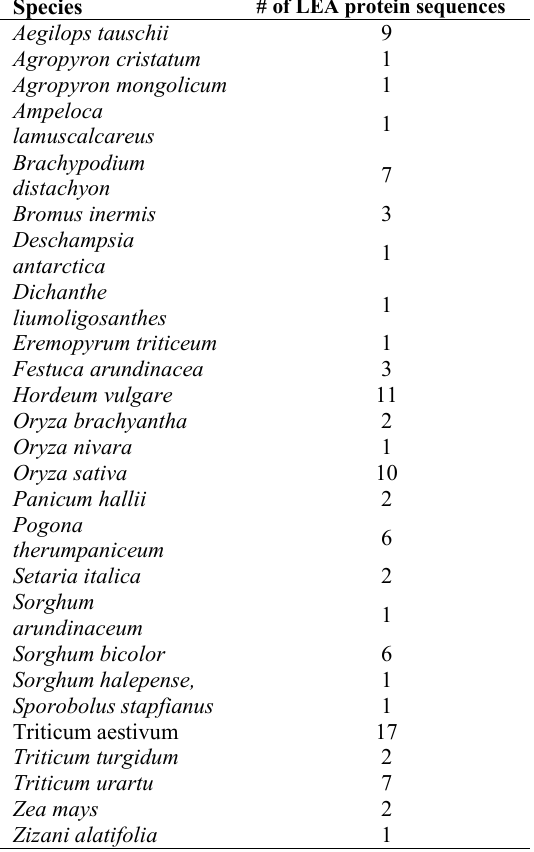
Fig. 2. The nucleotide sequence of amplified regions using the designed hva1 forward and reverse primers shows similarity with the sequences registered in NCBI for the hva1